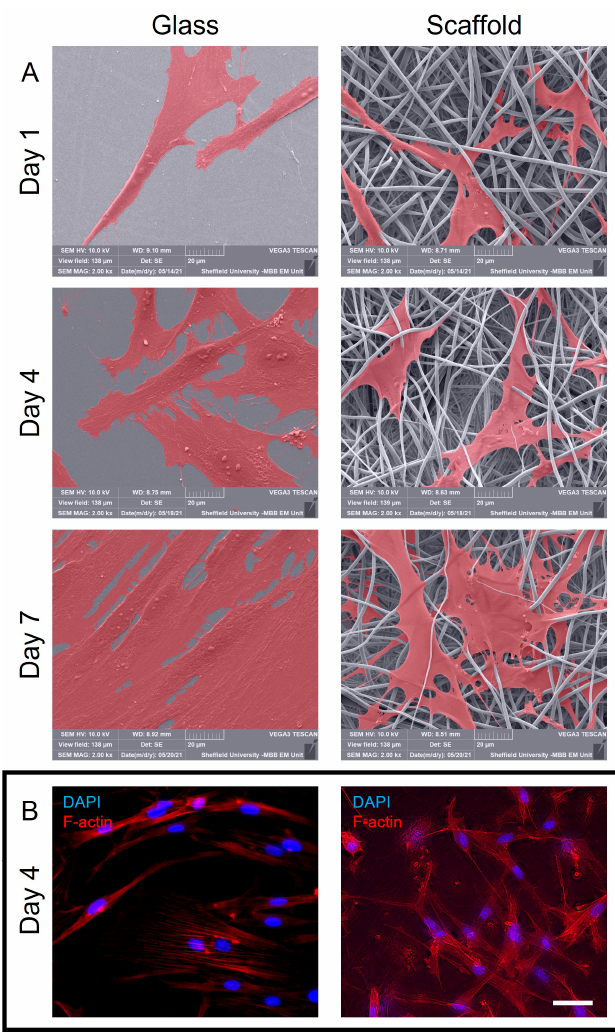
Figure 7. ( A ): Representative SEM images showing NOF morphology on glass cover slips and electrospun scaffolds. Images are magnified 2000× and scale bars are included with each image. Fibroblasts have been artificially coloured red using Adobe Photoshop 2021. ( B ): F-actin (red) immunofluorescent staining and DAPI (blue) staining of NOF grown on TCP and scaffolds. The scaffold grown fibroblasts were imaged using a z-stack; TCP is a single focus image. Scale bar = 50 µ